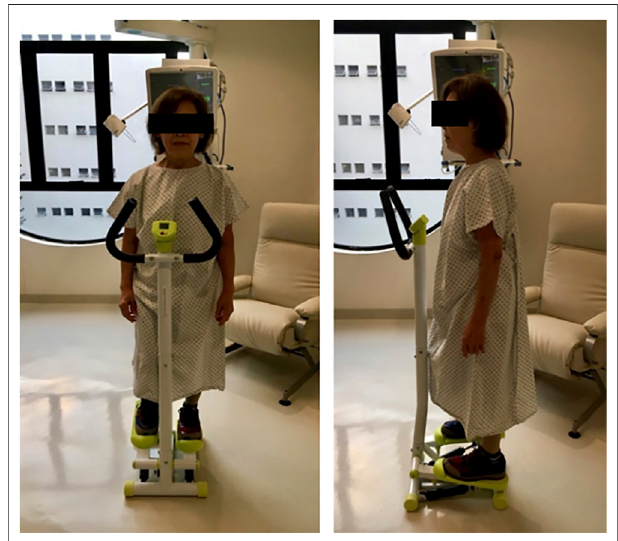
FIGURE 1 | Pictures of the stepper and position adopted during the six- minute stepper